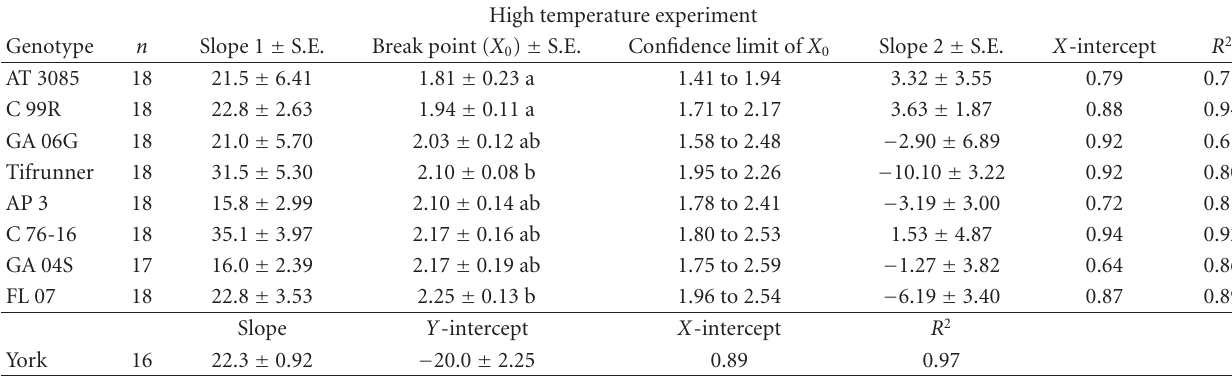
Figure 1: Transpiration rate versus vapor pressure deficit (VPD) for cultivars AP3 and C 76-16 in High Temperature (HT) and Low Temperature (LT) experiments. Table 2: Linear regression analysis of response to vapor pressure deficit based on the results from the High Temperature experiment. The number of data for each cultivar is listed in the column labeled n and the data are followed by the standard error of the mean. For those cultivars represented by the two-segment regression, slope 1 is for the regression segment below the breakpoint and slope 2 is for the regression above the breakpoint. Break point values followed by the same letter are not significantly di ff erent based on their confidence